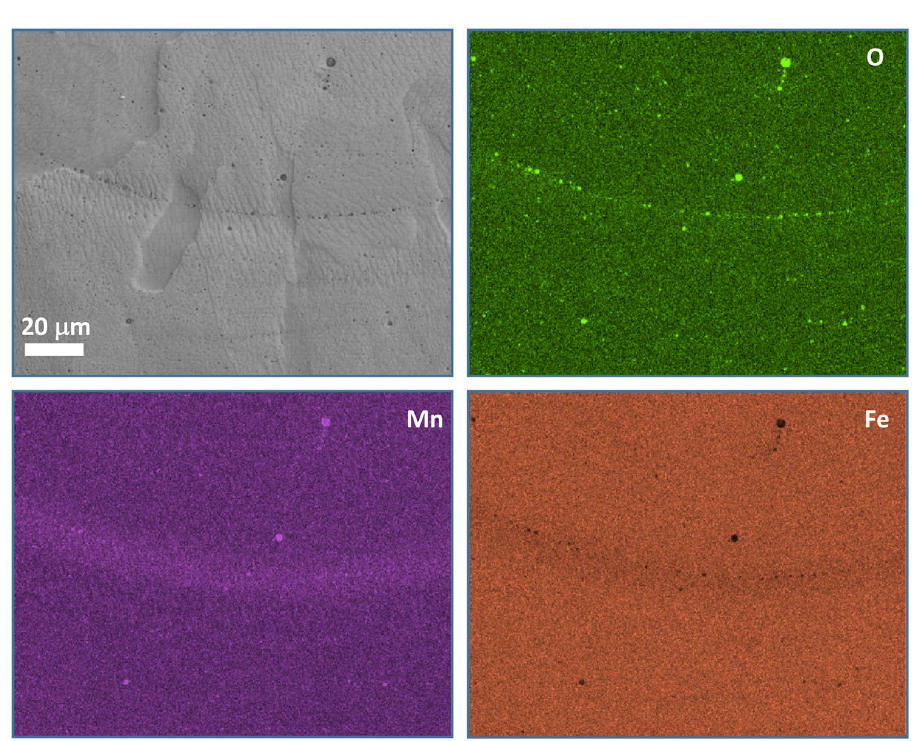
Figure 4. SEM–EDS mapping of Mn, O and Fe at the bottom of the melt pool with clearly visible small Mn oxides on the melt-pool boundary in the S-350/800